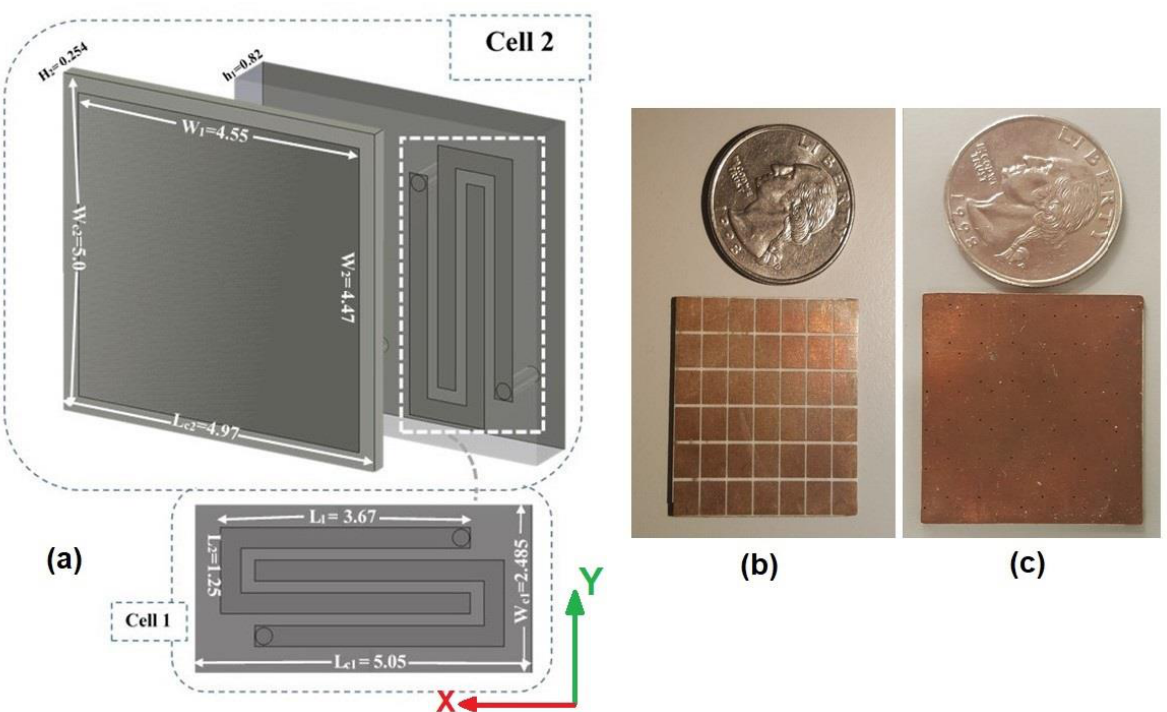
Figure 3. ( a ) Magneto Dielectric (MD) unit cell (Cell 1) and MD-AMC unit cell (Cell 2) configuration; The fabricated cells ( b ) Front view, ( c ) Back view.